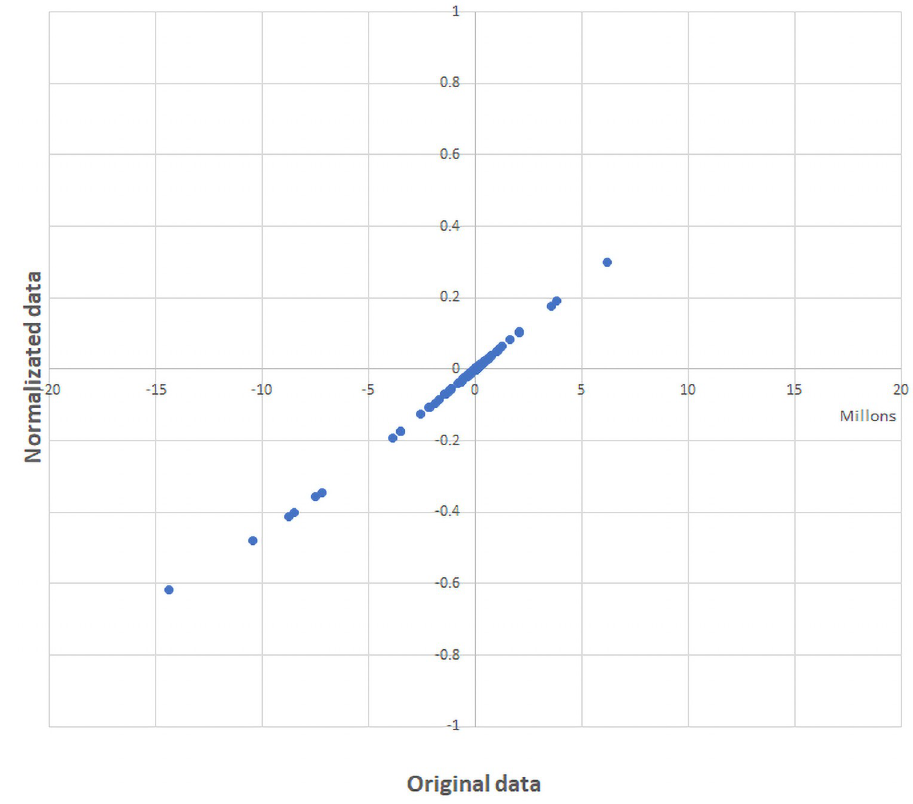
Fig 11. Response curve of normalized data of general